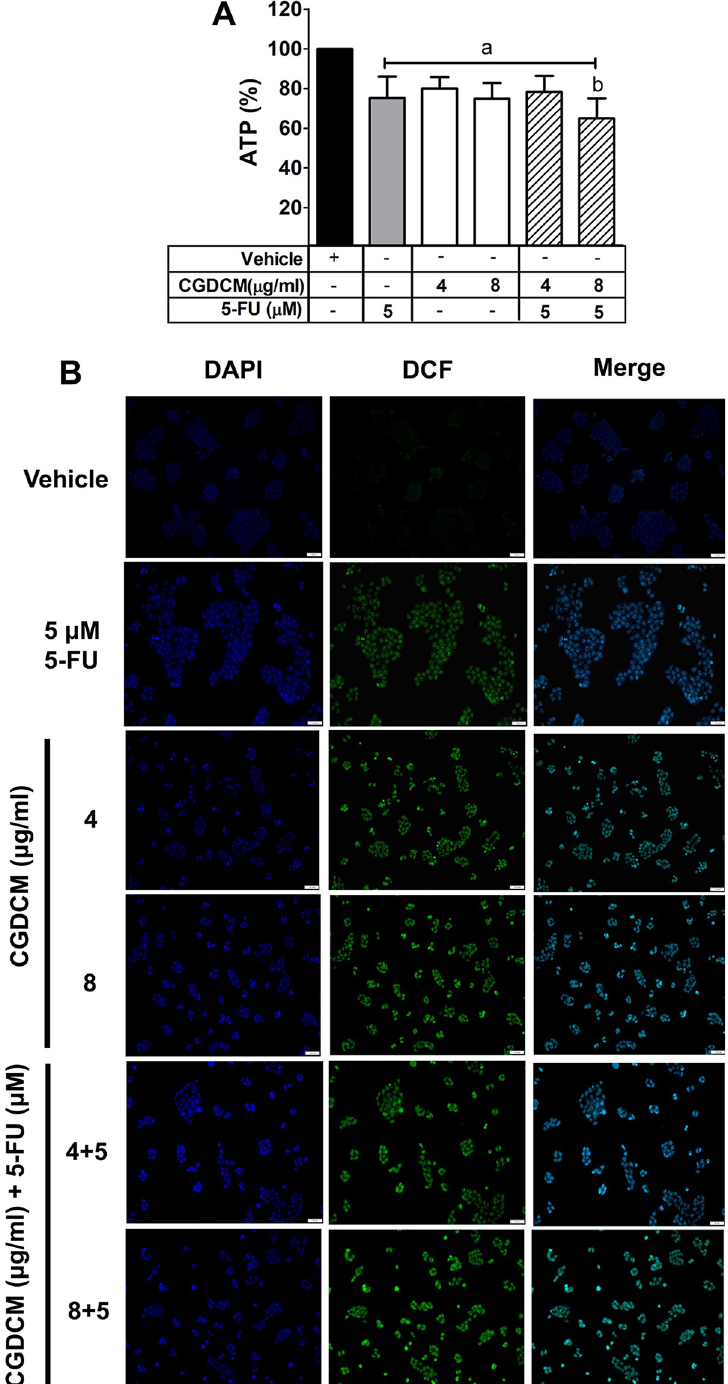
Fig 6. Effect of CGDCM and 5-FU on the production of ATP and ROS in HCT116 cells. The levels of ATP and ROS in HCT116 cells after treatment with CGDCM, 5-FU, and combinations of CGDCM (4, 8, and 10 μ g/mL) with 5-FU (5 μ M or 0.65 μ g/mL) for 24 h. The ATP levels in HCT116 cells were analyzed using an ATP assay kit ( A ). The ROS levels in HCT116 cells were analyzed by fluorescence microscopy; bars = 50 μ m ( B ). The data are presented as mean ± SD. a; p < 0.05 vs. vehicle group. b; p < 0.05 vs. 5-FU group. Abbreviations: CGDCM, C . gigantea dichloromethane extract; 5-FU, 5-fluorouracil; ATP, adenosine triphosphate; DAPI, 4 0 ,6-Diamidino-2-phenylindole dihydrochloride; DCF, 2 0 ,7 0 -dichlorofluorescein.